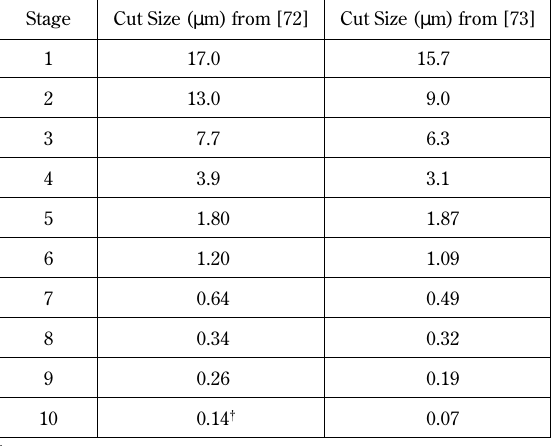
Table 8 Stage d 50 values for the QCM impactor at 0.24 L/min